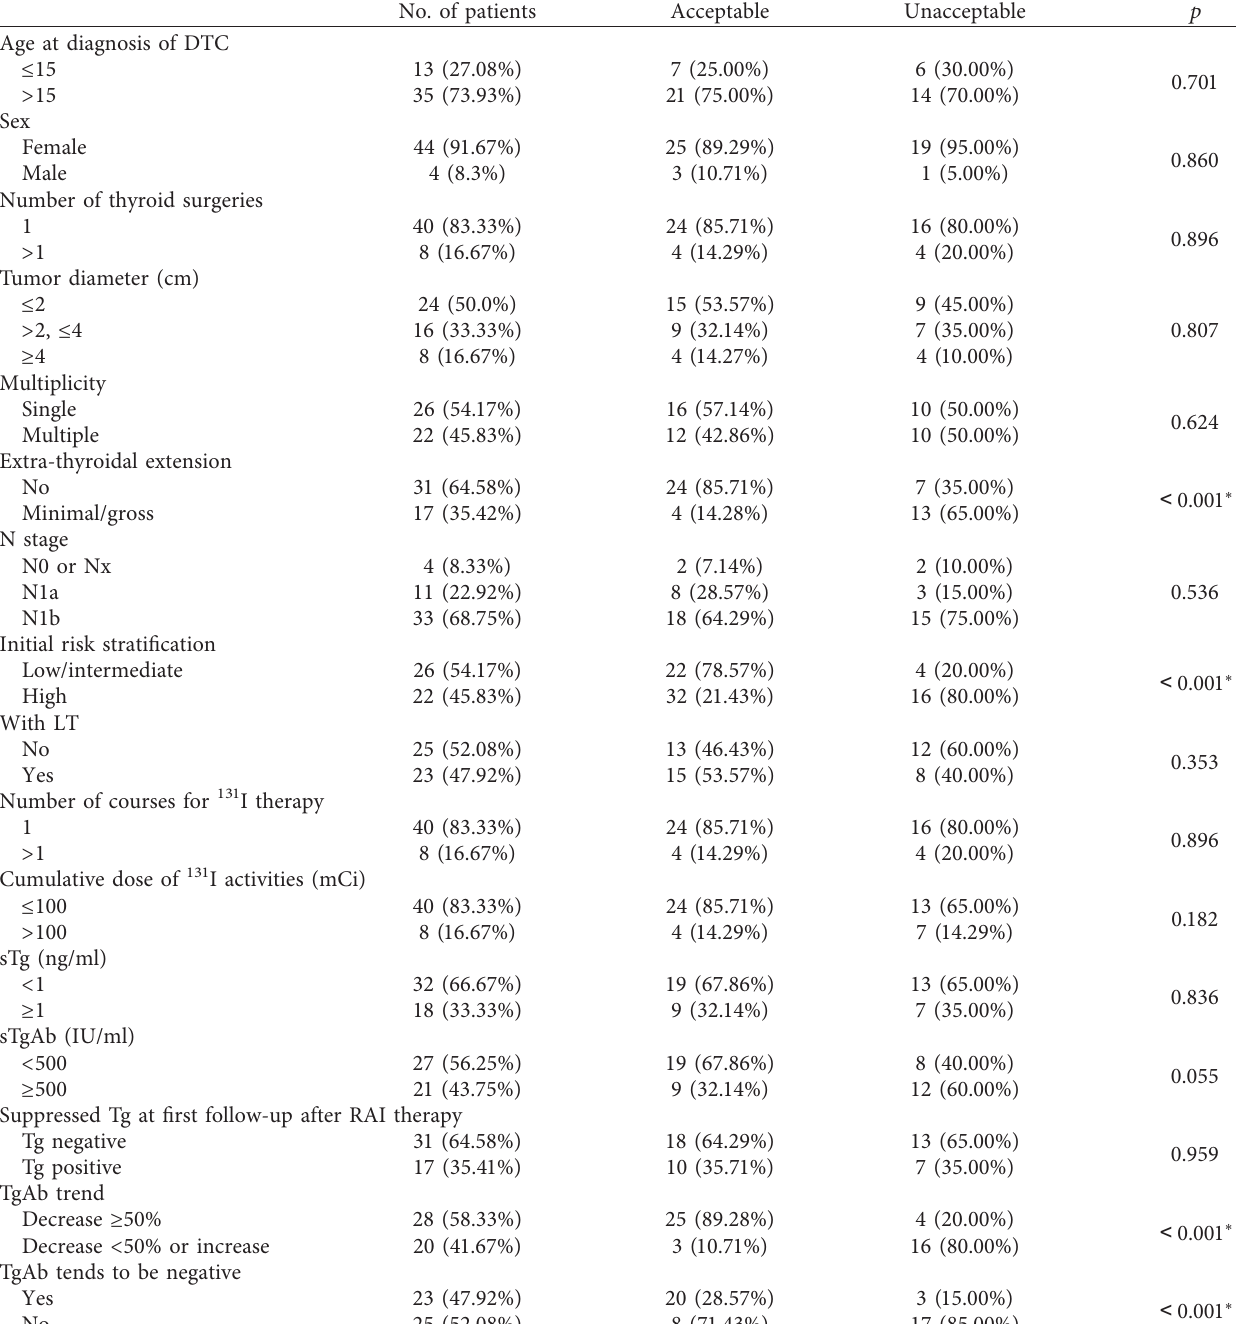
Table 2: Univariate analysis clinicopathologic factors associated with responses to